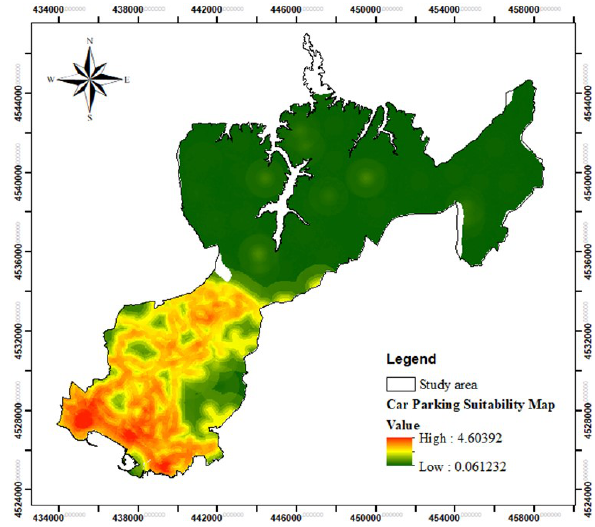
Figure 7. Car parking site selection application in Pendik/Istanbul